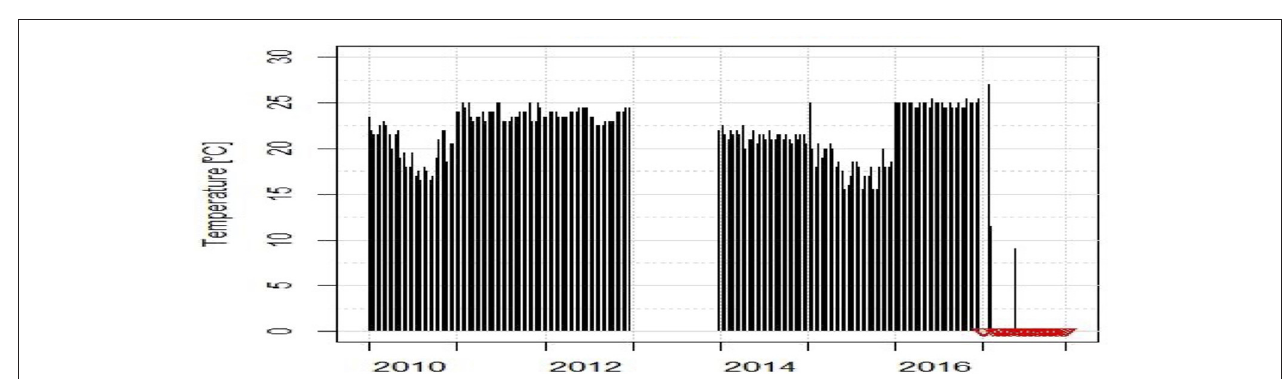
FIGURE 4 | An output from the quality check procedure showing (in red) rainfall data mixed up with temperature measurements.